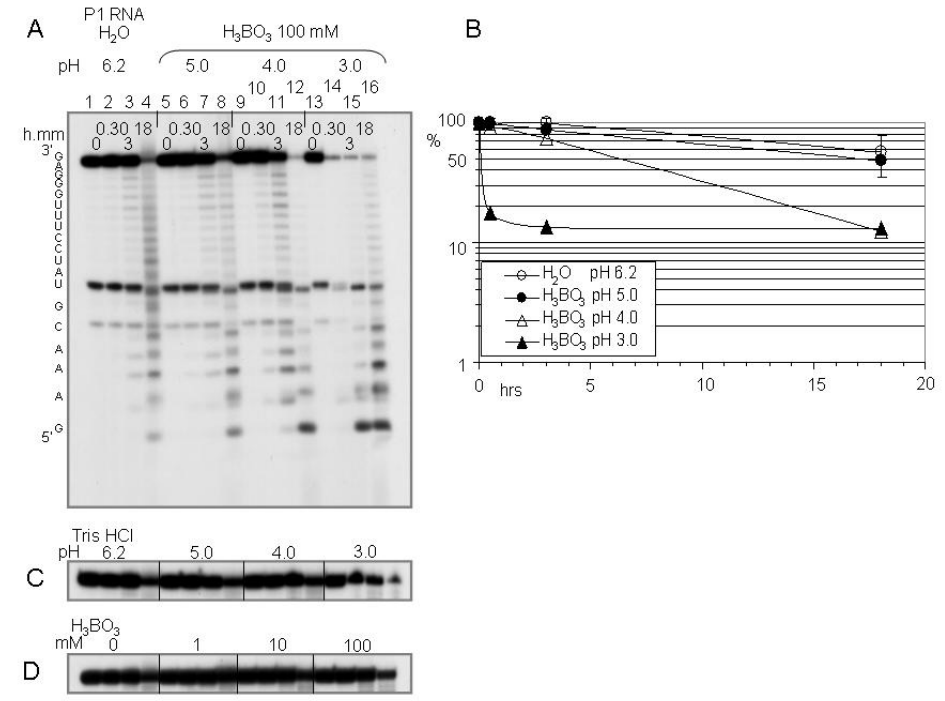
Figure 4 . RNA stability in boric acid